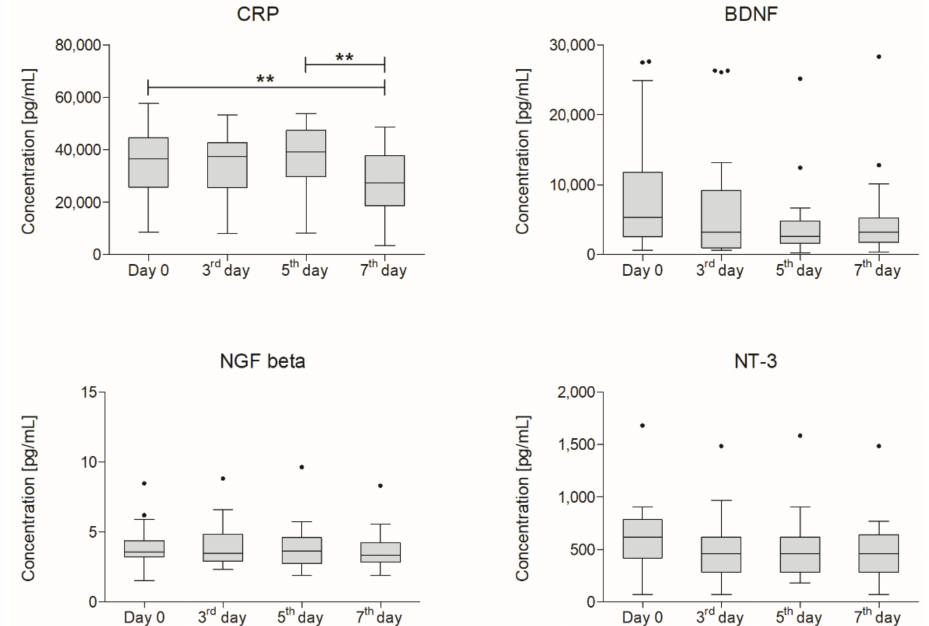
Figure 1. Boxplot representing concentrations of analyzed factors in plasma (pg / mL) measured on days zero, three, five, and seven after intrathecal administration of bone marrow-derived lineage-negative cells ( n = 18). Significance of the changes between analyzed timepoints was assessed using Wilcoxon signed-rank test. Whiskers range from 10th to 90th percentile. Horizontal line inside the box indicates the median. Level of significance-** p < 0.01. CRP: C-reactive protein; BDNF: brain-derived neurotrophic factor; NGF: nerve growth factor beta; NT-3: